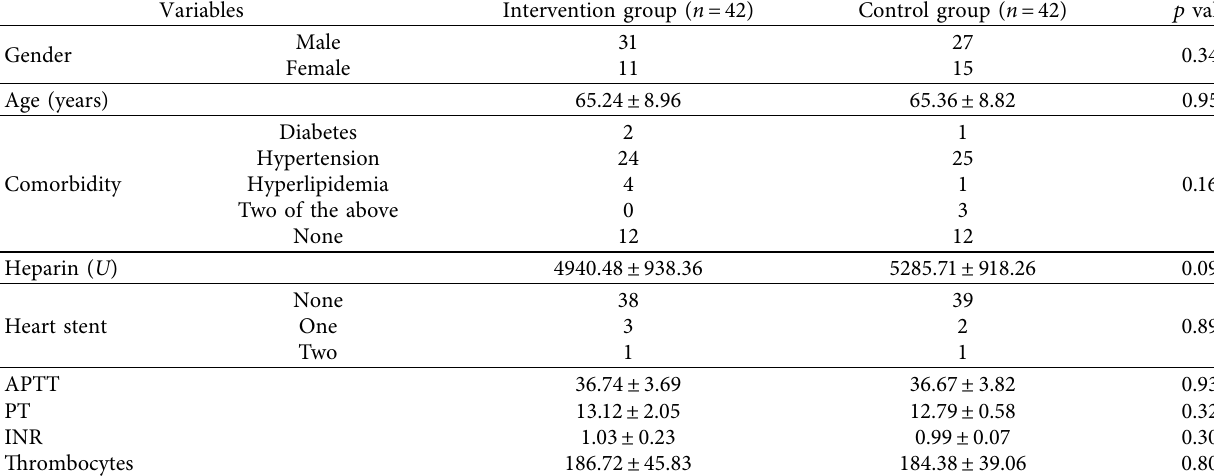
Table 2: Baseline clinical characteristics.